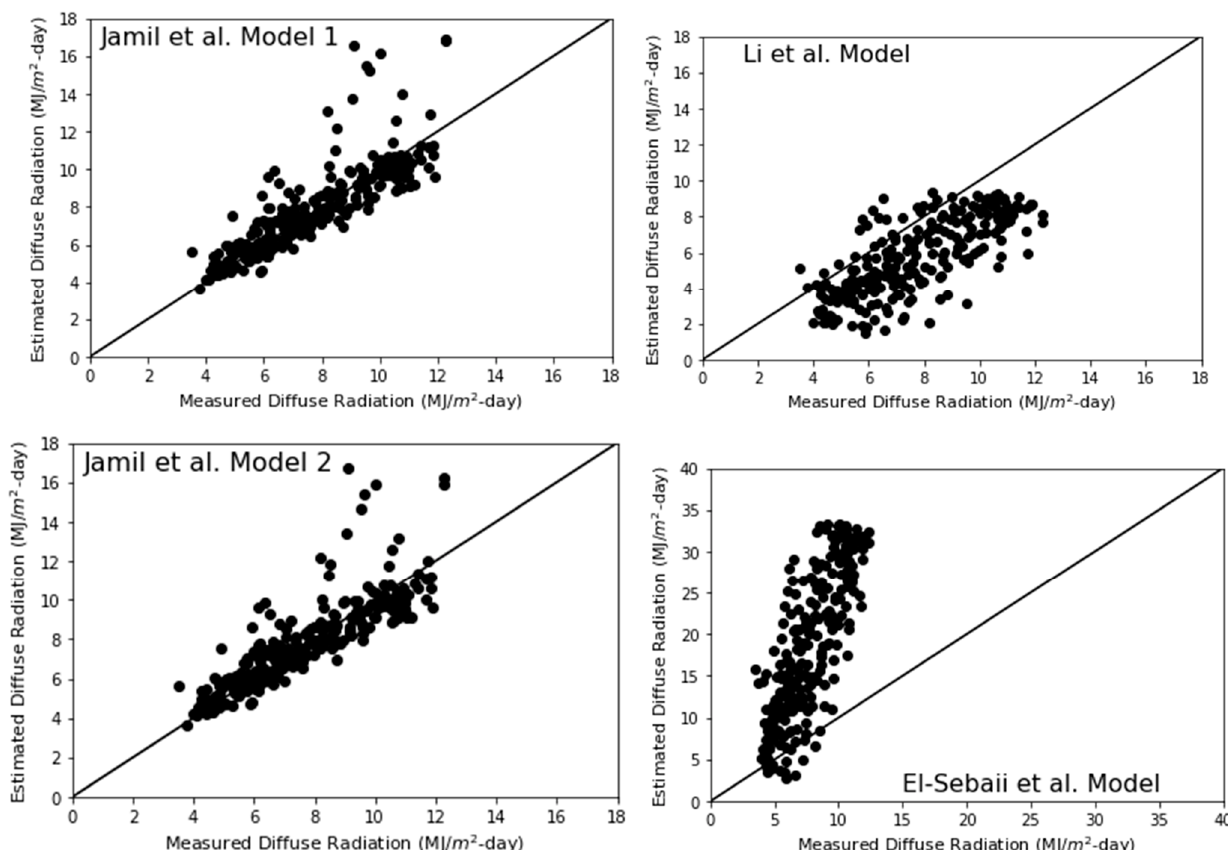
Figure 7. Plot depicting predicted and measured DSR from models selected from the literature.